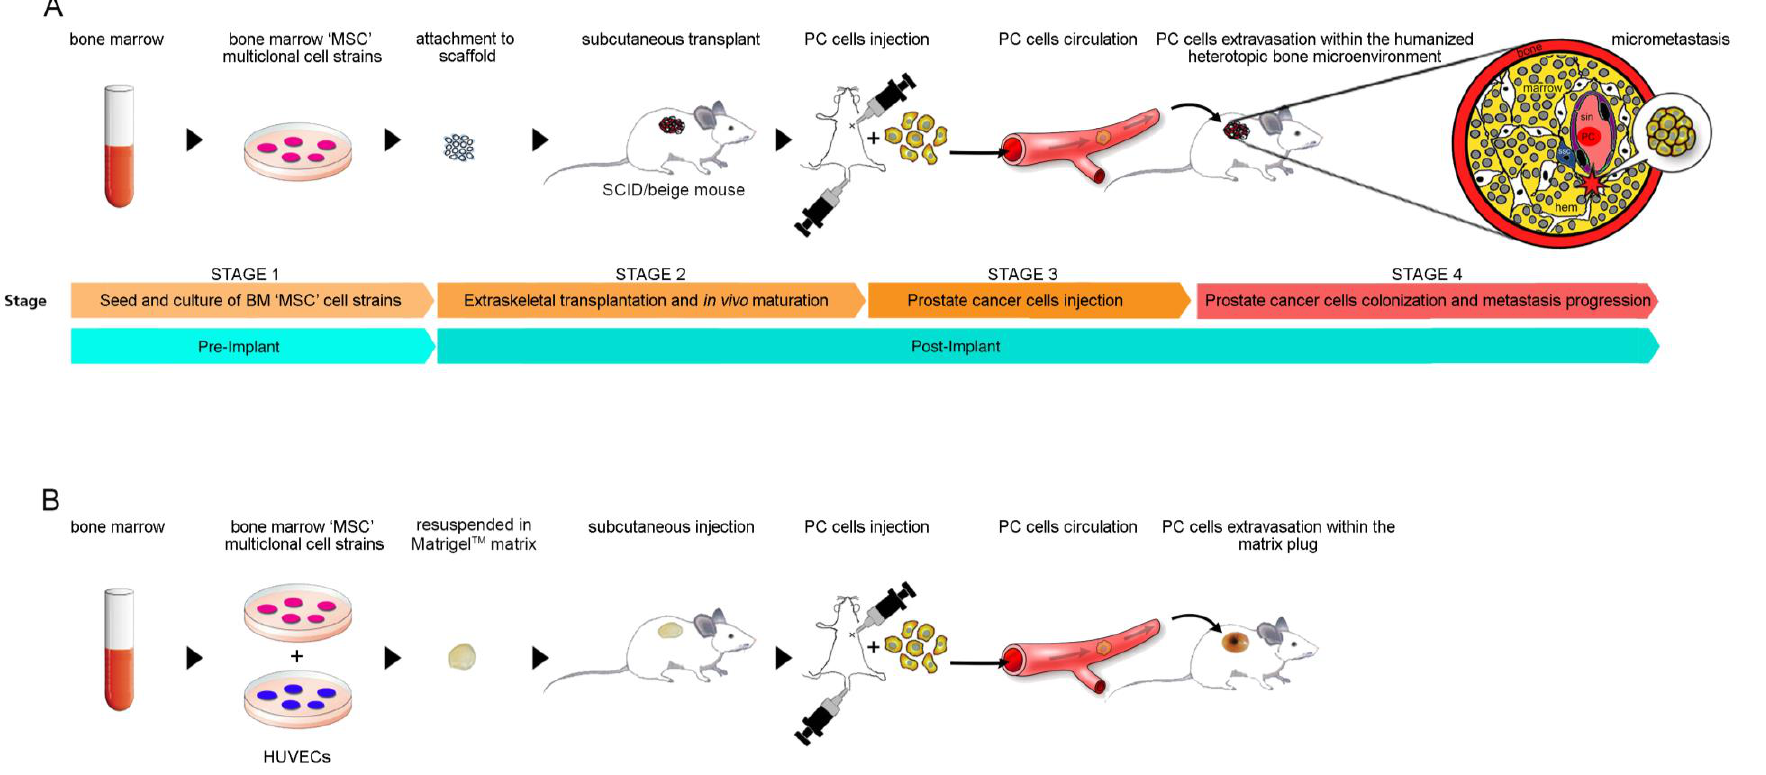
Figure 1. ( A ) experimental design for generation of prostate cancer metastasis in Severe Combined Immunodeficiency (SCID) / beige mice bearing heterotopic humanized bone / Bone Marrow (BM) ossicles; ( B ) experimental design for generation of prostate cancer metastasis in SCID / beige mice carrying heterotopic Matrigel TM matrix with co-transplanted hBMSCs and HUVECs. Prostate cancer (PC) cells. Human Umbilical Vein Endothelial cells, HUVECs.